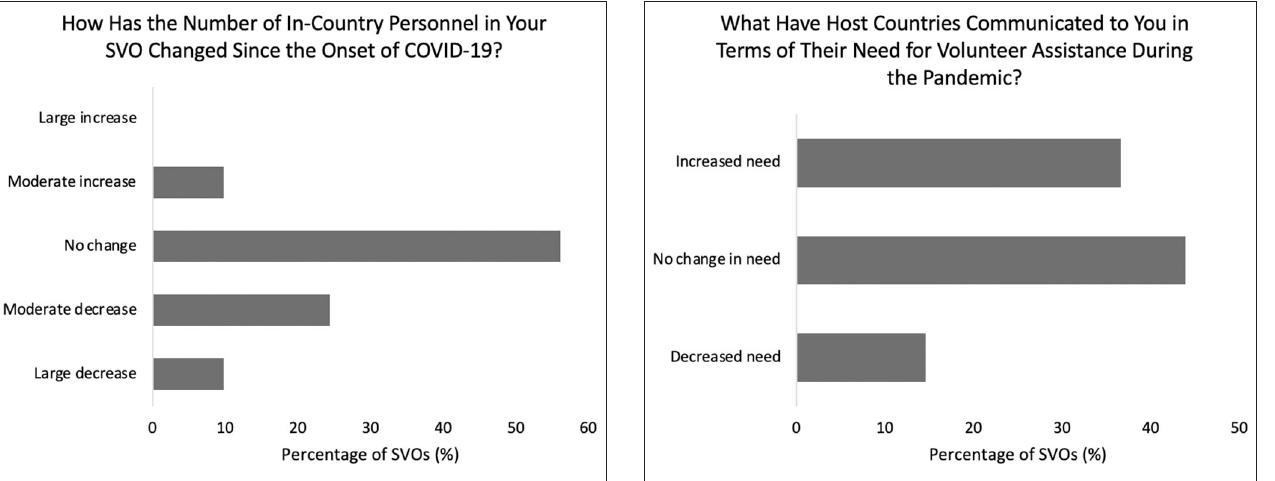
FIGURE 6 | Changes in host country need for volunteer assistance during the pandemic.